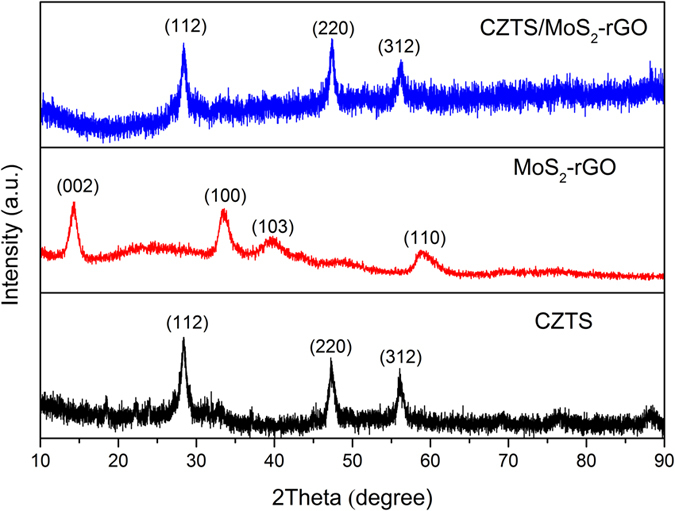
Powder XRD patterns of as-synthesized CZTS, MoS2-rGO, and CZTS/MoS2-rGO composite.